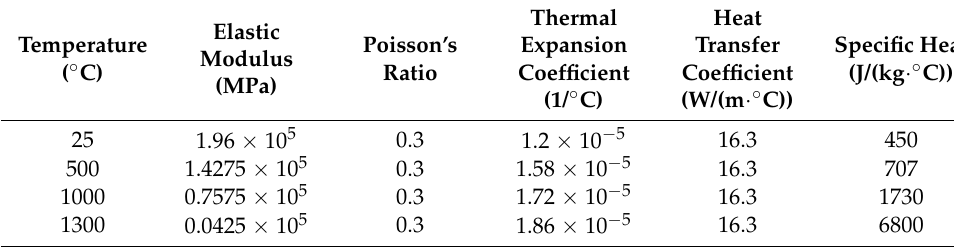
Table 1. Thermophysical properties of materials in Model I